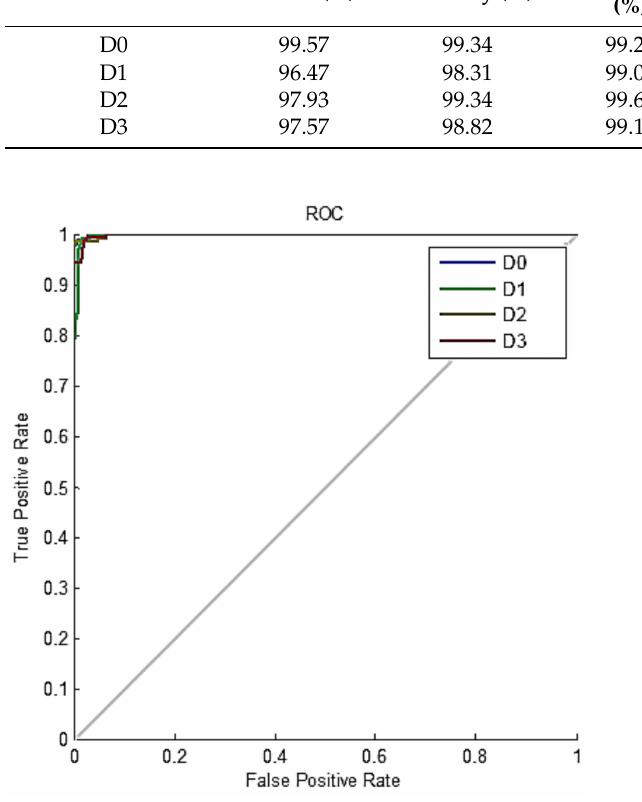
Figure 10. ROC curves of the ANN-ICA classifier for the four classes for the best training case.